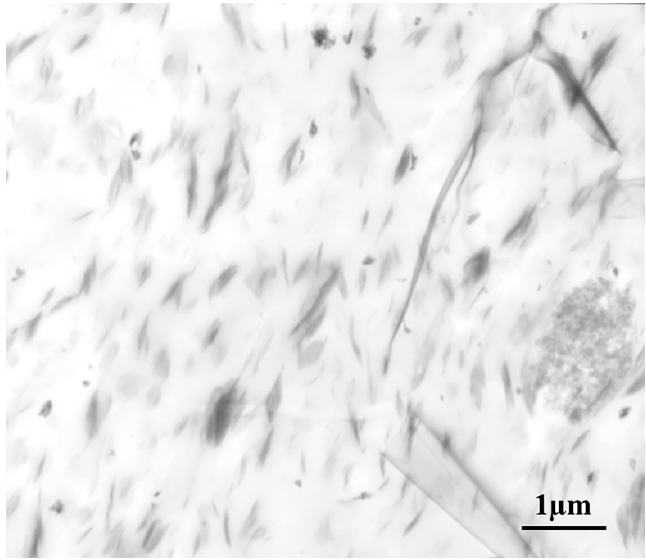
Figure 2. Transmission electron microscopy (TEM) image of the nanorubber highlighting the dispersed and intercalated structure of the layered silicates.